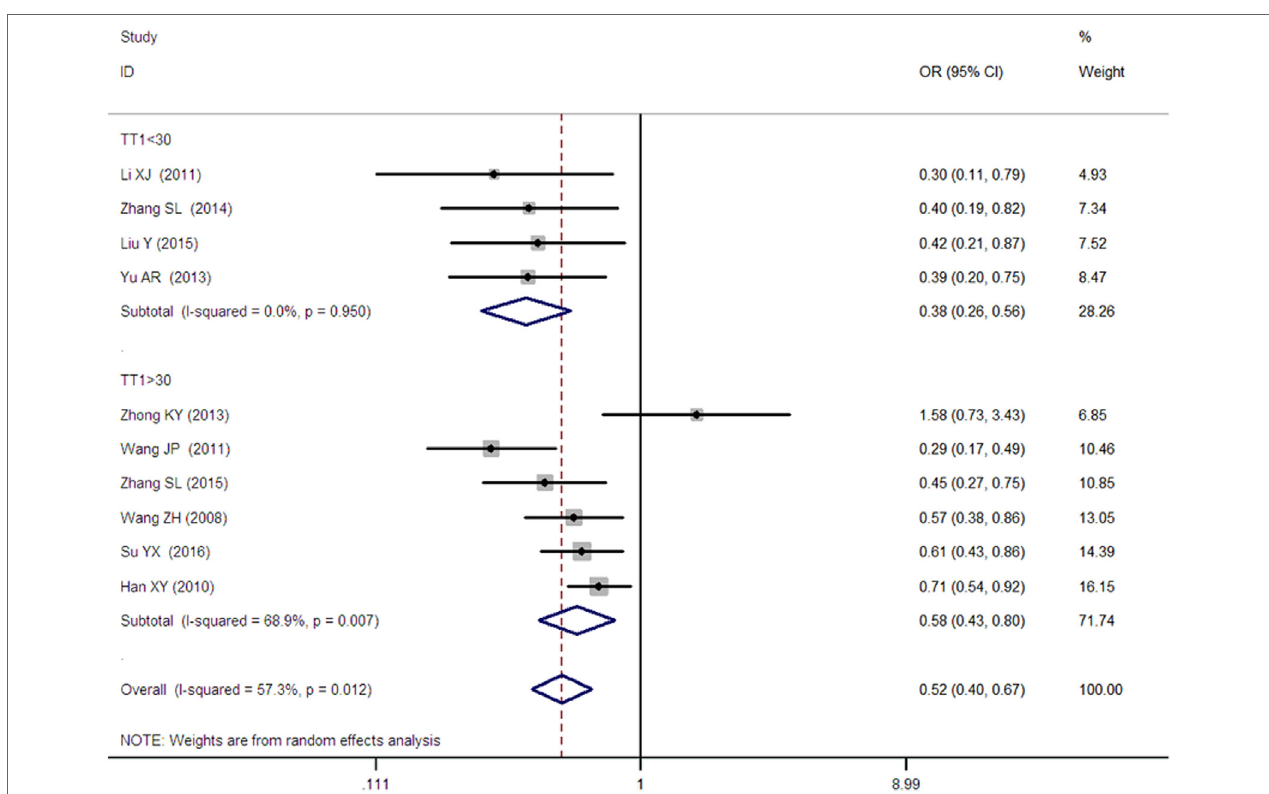
FiGURe 4 | Forest plot of type 2 diabetes mellitus associated with SLC30A8 gene rs13266634C/T in the Chinese population under a homozygous genetic model (TT vs.